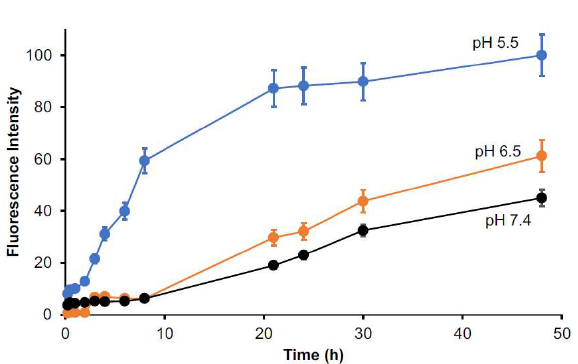
Figure 3. Release profile of SMA@mTHPC. SMA@mTHPC was dissolved in sodium phosphate buffer of different pH values and sealed in dialysis bags. After the indicated incubation time at 37 ◦ C, the mTHPC released from the dialysis bags were measured and quantified by recording fluorescence intensity. A constant in vitro release rate of ≈ 20% per day was observed at neutral pH (7.4), whereas higher release was found at weak acidic pH (6.5, 5.5). Data are mean ± SD, n = 4. See text for